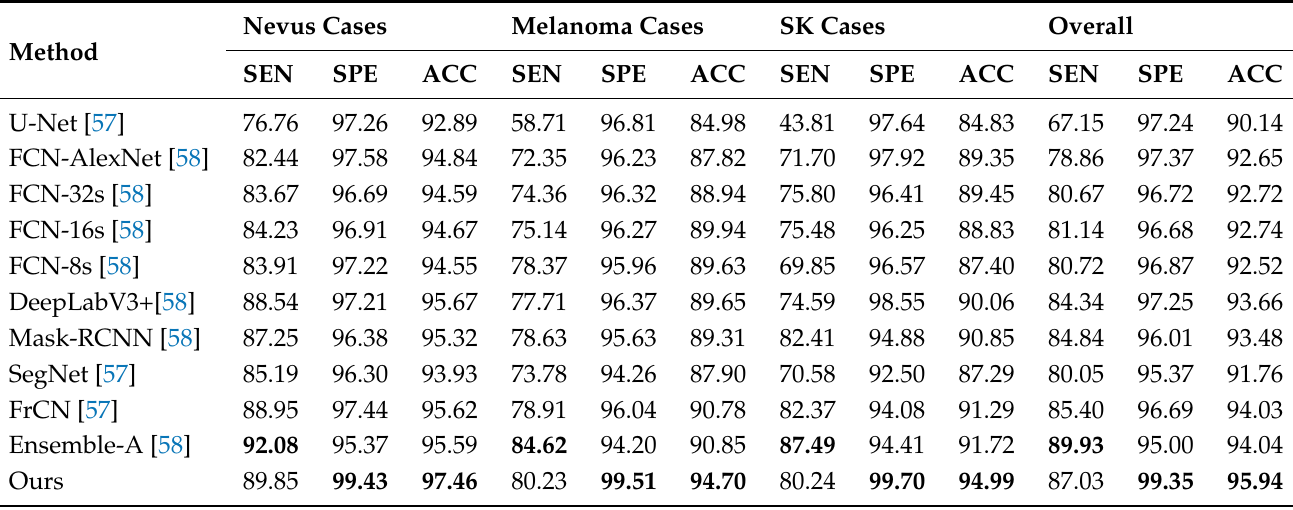
Table 9. Performance evaluation of sensitivity, specificity, and accuracy performance of different attention modules and CSFAG modules on the ISIC-2017 data set using baseline as the basic structure. Bold data indicates that the value is the maximum value in this indicator.